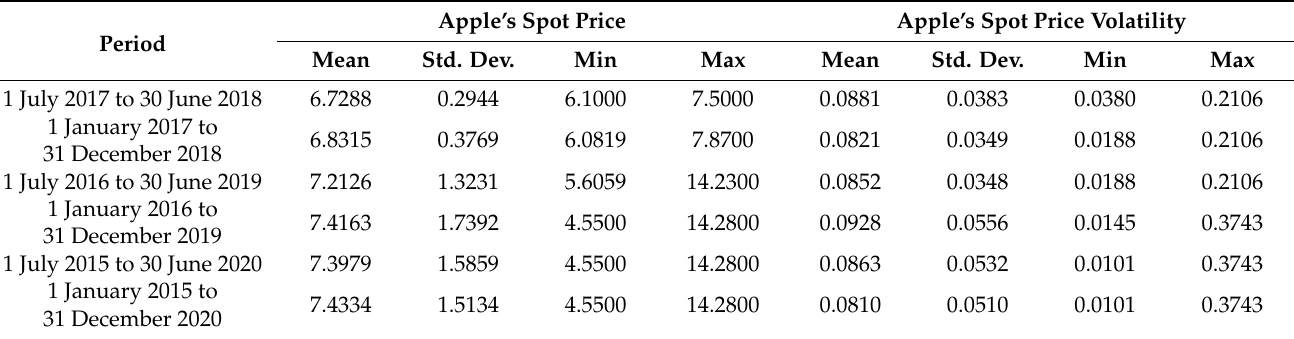
Table 1. Descriptive statistics of apple’s spot price and volatility.